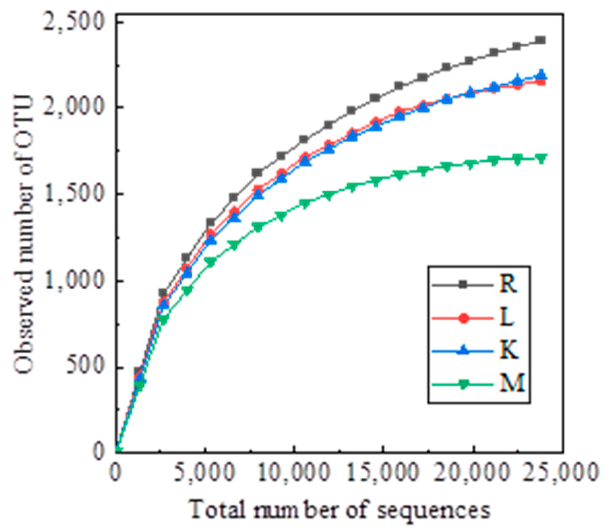
Figure 2. Soil bacterial OTU rarefaction curves with different vegetation types.